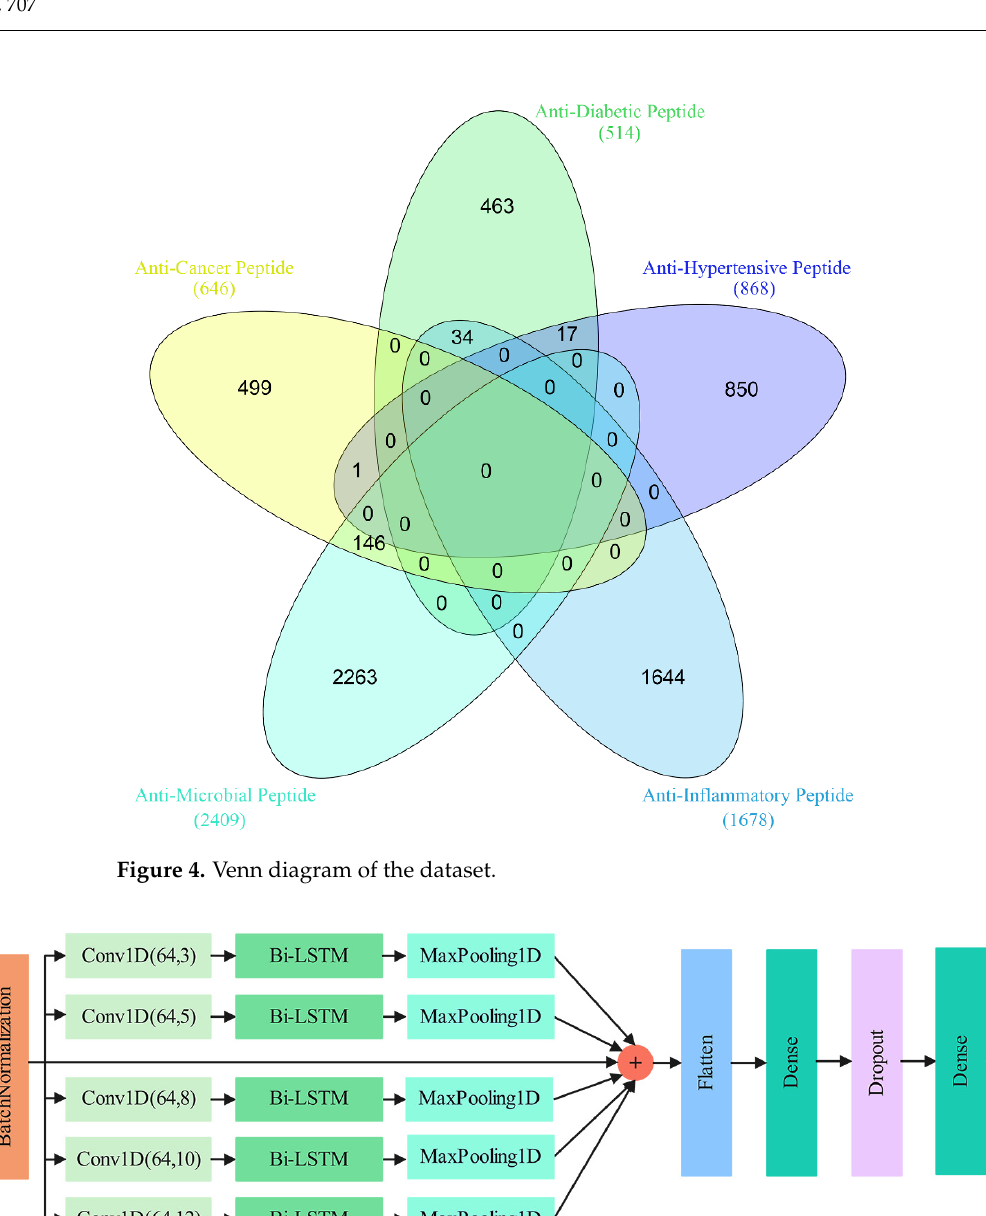
Figure 5. The architecture of the MPMABP. Conv1D represents the CNN layer, MaxPooling1D the pooling layer, and Dense the fully connected layer.